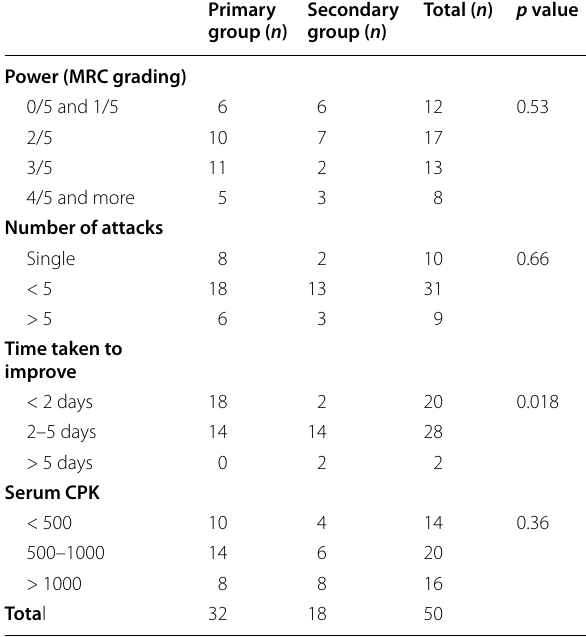
Table 1 Table showing power grading, number of attacks, time taken to improve and serum CPK levels in two groups